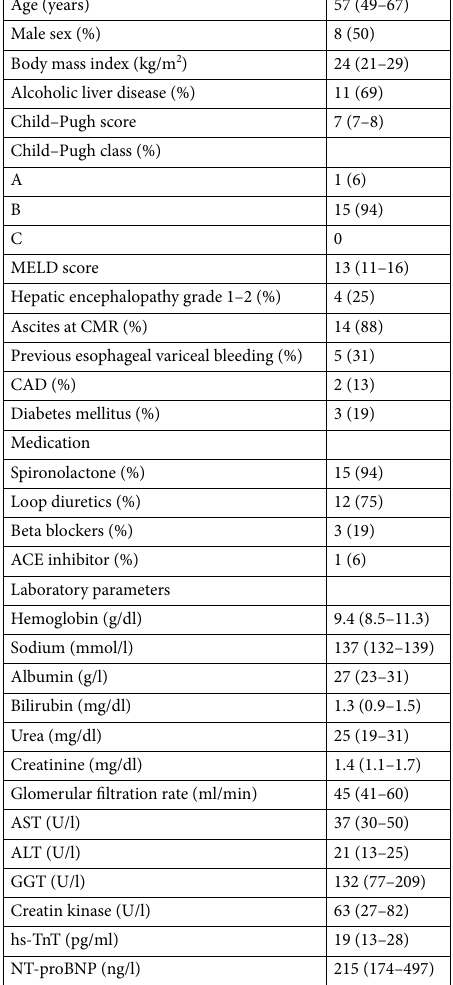
Table 1. Patient characteristics of all patients with follow-up CMR (N = 16). Values are median (interquartile range) or n (%). ACE inhibitor = angiotensin-converting-enzyme inhibitor; AST = Aspartate Aminotransferase; ALT = Alanine Aminotransferase; GGT = Gamma-Glutamyl Transferase; BMI = body mass index; CAD = coronary artery disease; CMR = cardiovascular magnetic resonance imaging; hs-TnT = high-sensitive Troponin T; MELD score = Model for End-stage Liver Disease score; NT-proBNP = N-terminal pro-B-type natriuretic